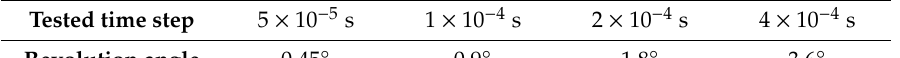
( b ) Figure 8. The effect of vapor properties on vapor volume: ( a ) seed density and ( b ) seed diameter. The time step Δ t specified by different researchers varies, but the order of magnitude is mostly between 10 − 5 and 10 − 4 s [35–37]. Since the rotation speed was specified as 25 rps in the present